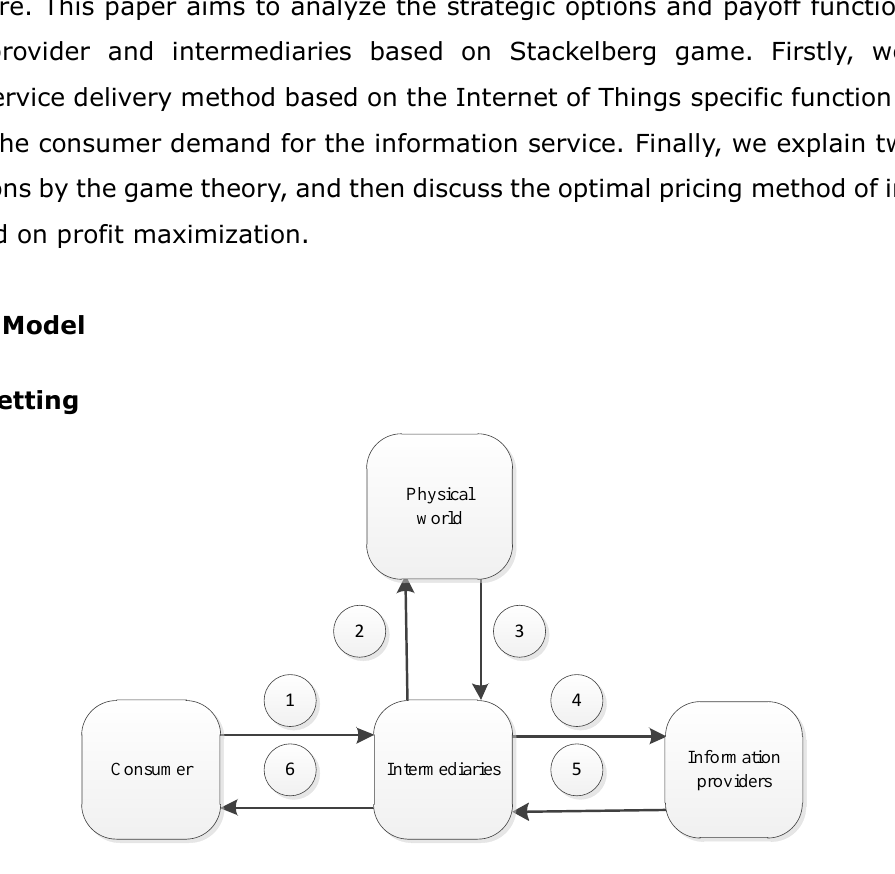
Figure 1. The delivery routine of information service in the